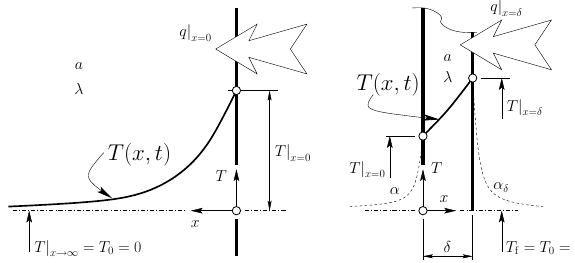
Fig. 7. A semi-infinite body as a calibration tool of the TOIRT method (left), and the heat transfer surface of an infinite plate (right). The boundary condition of the harmonic oscillating heat = ¯ q + ˆ q sin( ω t − β ) is applied to the heat transfer sur- flux q | x = δ face (wall) with the TOIRT method (the Wandelt-Roetzel solu- tion assumes ¯ q = 0 and β = 0).